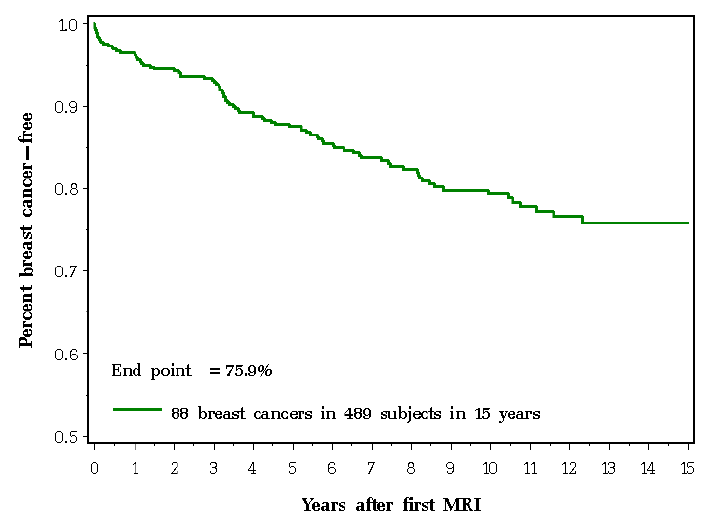
Figure 1. Probability of remaining breast cancer-free following first magnetic resonance imaging (MRI) screening.